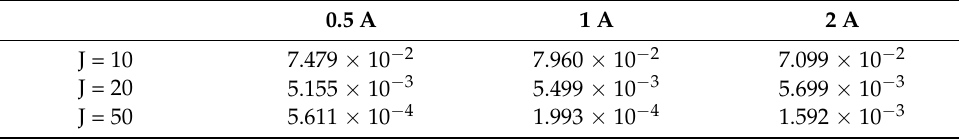
Figure 26. Pressure drop of the gap for different mesh density under the excitation currents of 0.5 and 2 A. Table 2. Relative difference values of peak pressure drop for different mesh density